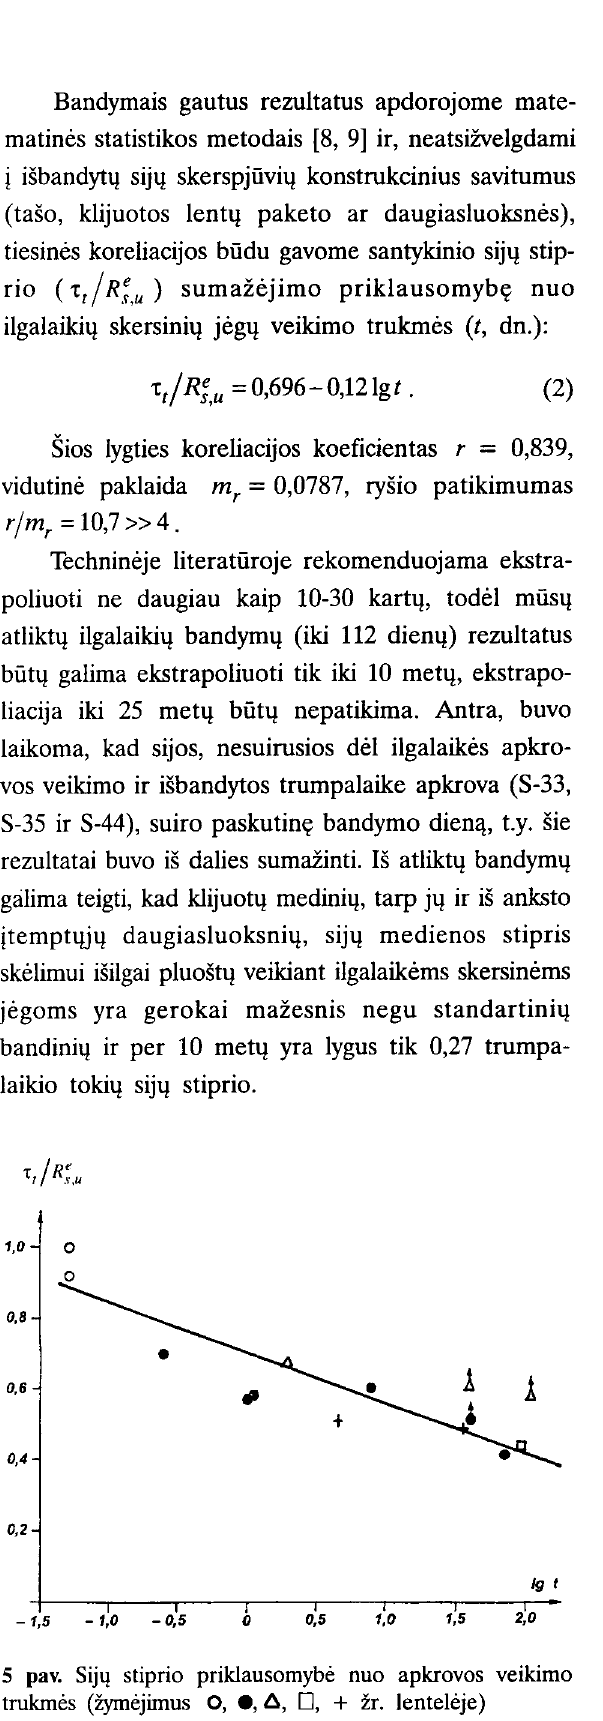
Fig 5. Relationship between the beam strength and the duration of loading ( 0, e, t::., D, + see Table)